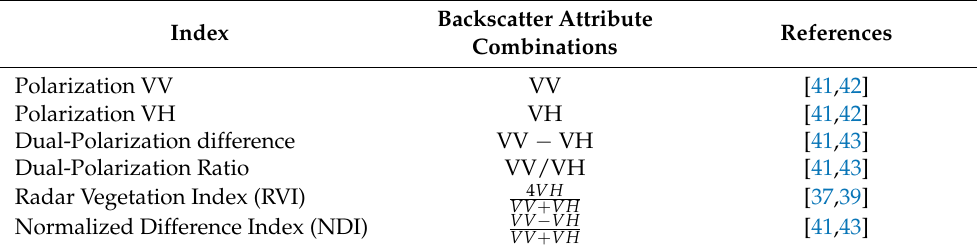
Table 2. C-SAR backscatter features used in oil palm research.